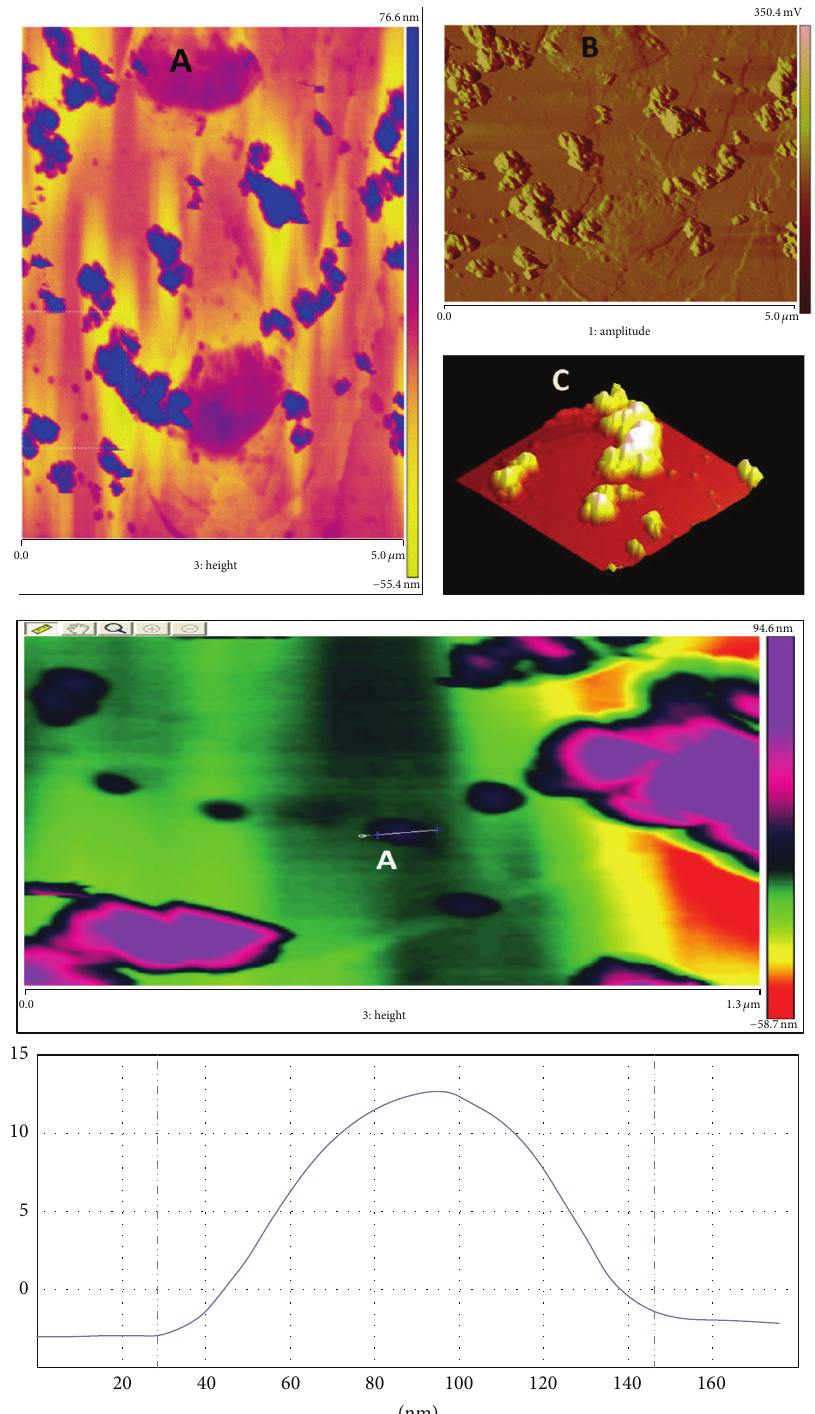
Figure 4: AFM height (contact) image (A) and amplitude (tapping) (B) of PM 570/SiO 2 CANPs (scan size is 5 𝜇 m) showing scattered particles with diameter ranging from 25 nm to approximately 200 nm and isolated islands of particles cluster with different sizes. 3D image (C) is a magnified image of the area outlined by a dashed square in (A). Obvious rims around the particles indicate that the particles are embedded in the gel. The height of the particle is shown with scale